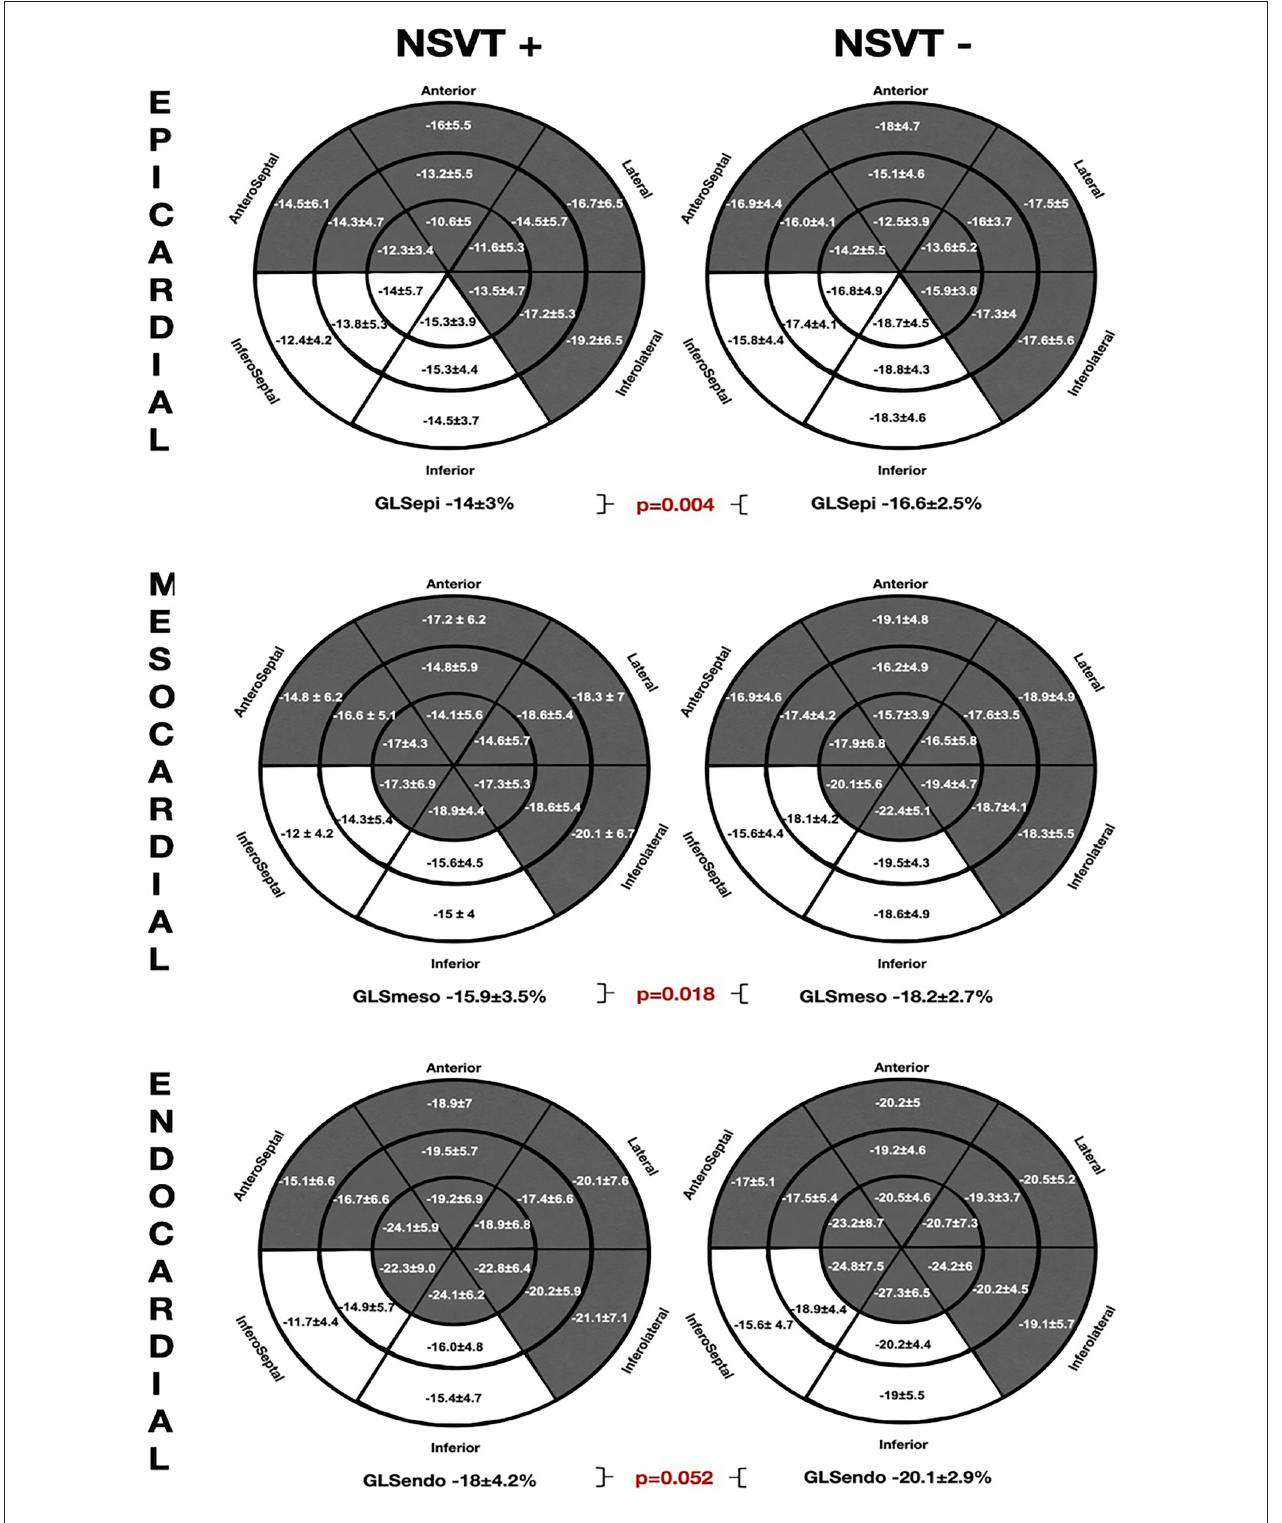
FIGURE 2 | The comparative global and regional layer-specific GLS analysis global between the NVST ( + ) and NSVT (–) groups represented in the left ventricular (LV) 18-segment models according to each myocardial layer. White areas remark significant differences in regional longitudinal strain between the groups. GLS, global longitudinal strain; NSVT, non-sustained ventricular